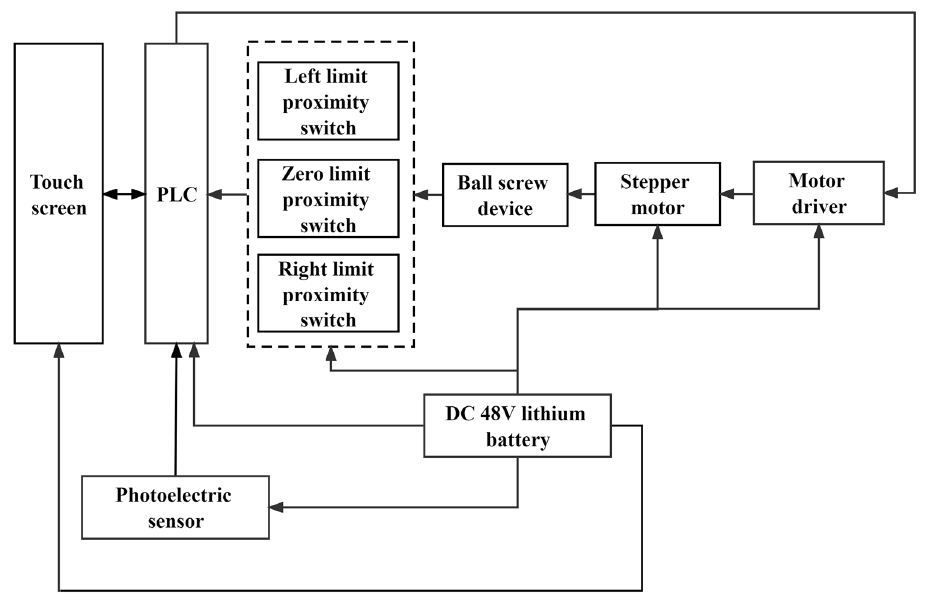
Figure 4. Automatic adjustment system of cu tt er height from the ground.